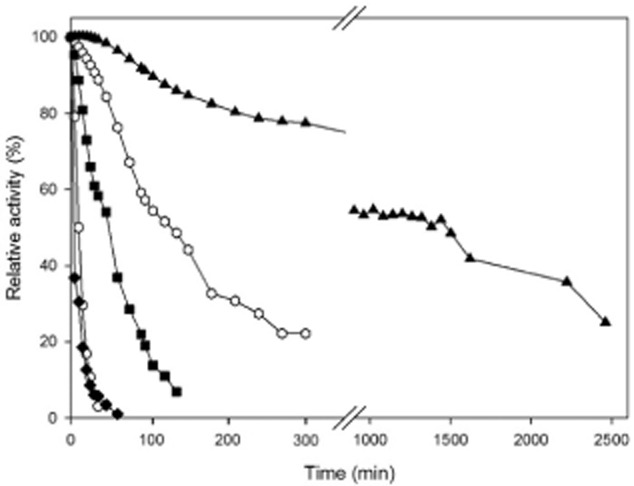
Effect of incubation at 37°C on activities of Udhs from A. tumefaciens, F. pelagi, O. granulosus, S. viridochromogenes and P. syringae presented as relative activities. Hexagon, F. pelagi UDH; Squares, A. tumefaciens UDH; Triangles, O. granulosus UDH; Circles, S. viridochromogenes UDH; Diamonds, P. syringae UDH.